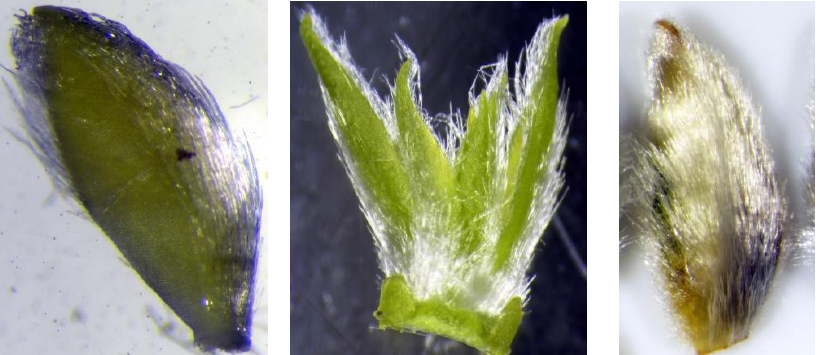
Figure 4. Outermost cataphylls of S. babylonica var. sacramenta ( left ), S. babylonica ’Babylon’ ( center ) and S. babylonica L. var. matsudana ‘Umbraculifera’ ( right ) after the bud scales were removed . In both taxa of S. babylonica —var. sacramenta and ’Babylon’—hairs were located only above the central vein and along the edge so that the part of the cataphyll blade lying between the central vein and the edge, remained glabrous, also there were no hairs on its top. In the cataphylls of S. matsudana ‘Umbraculifera’, the abaxial side is densely and evenly pubescent with long hairs.